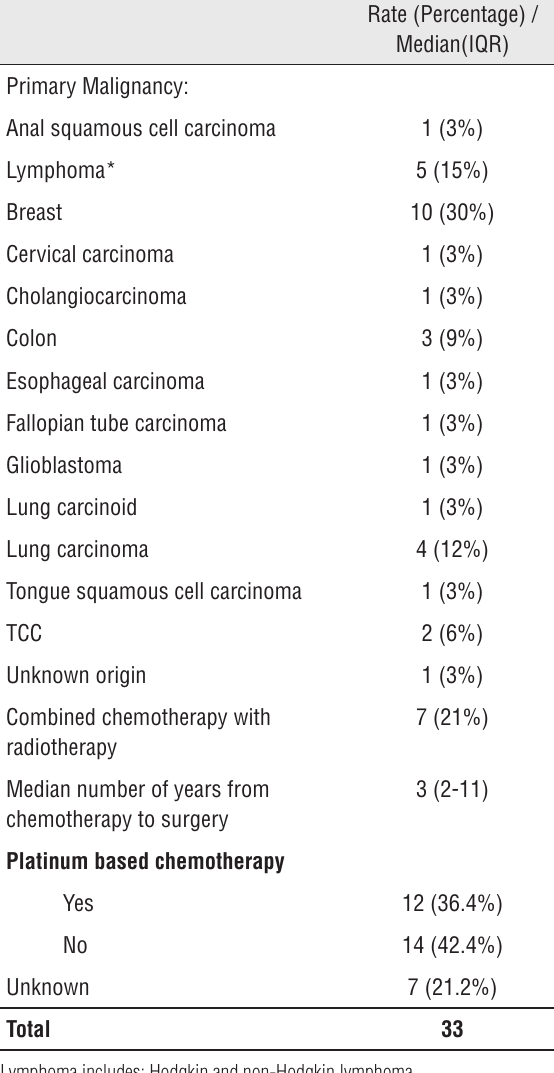
Table 4 - Primary malignancies and chemotherapy